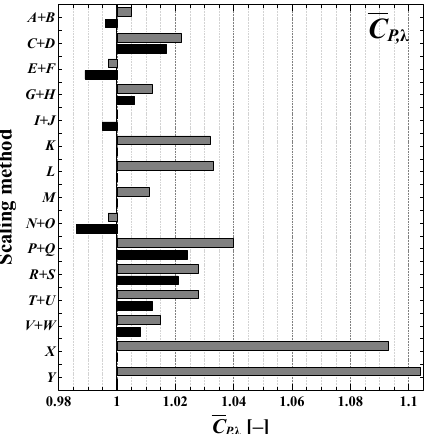
Figure 2. Mean values C P , λ of the model–ship power correlation factors C P , λ for all scaling methods λ . If the same scaling method was investigated with and without scaling to the Reynolds number of the self-propulsion test, the results are grouped together; the black bar stands for the no scaling to the self-propulsion test. The capital letters reference Table 5.